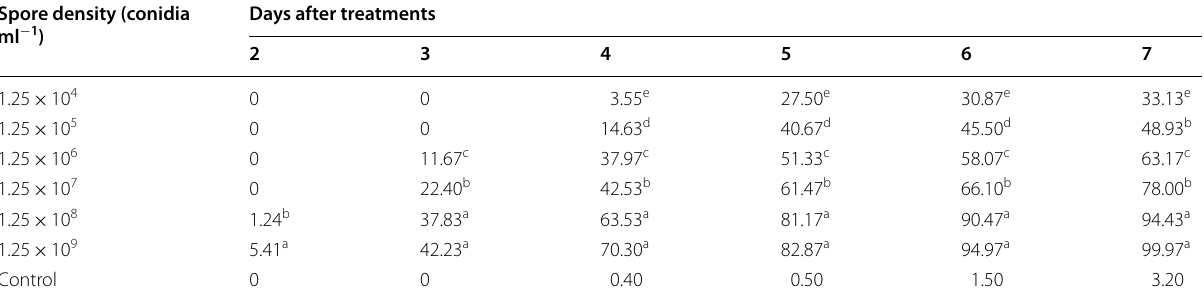
Fisher LSD Test, P < 0.01, Different letter indicates significant difference